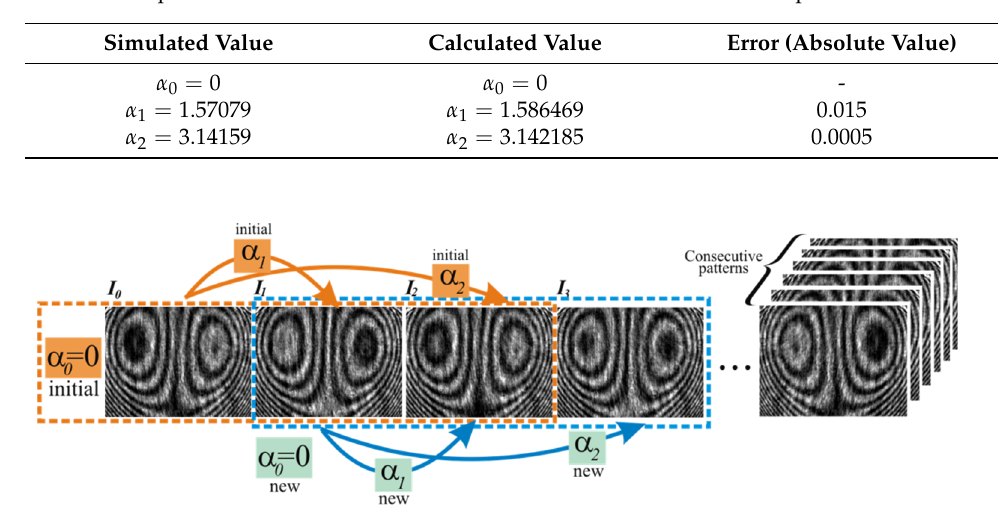
Figure 6. Experimental pattern captures.